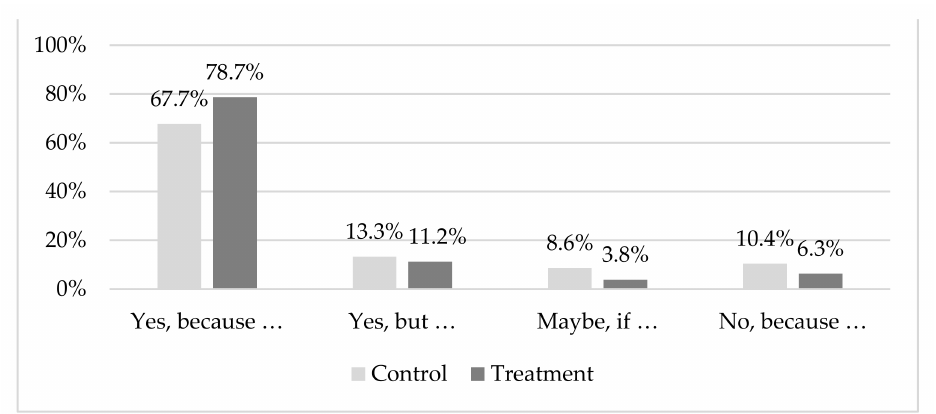
Figure 5. Responses to the question “Would you eat farmed duck fed an insect-based diet?” for the con- trol ( n = 279) and information treatment groups ( n = 286). Note: Pearson’s chi-squared (df) = 10.811 (3), p = 0.013; Cramer’s V= 0.138, p =